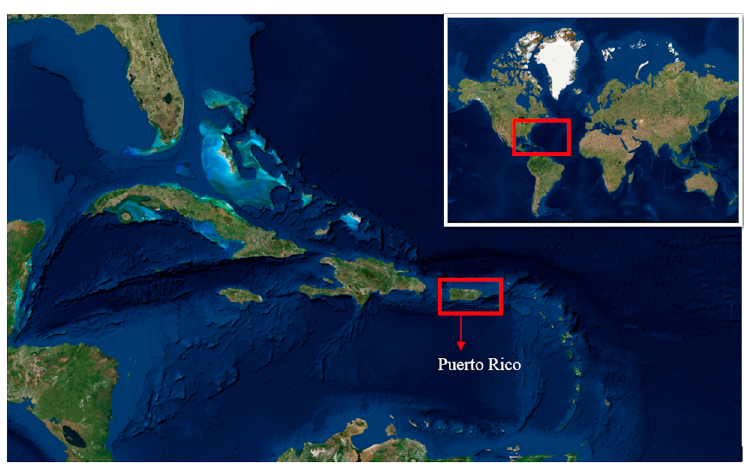
Figure 1. Location of Puerto Rico within the Caribbean. Puerto Rico is enclosed on the red rectangular and is located on the northwestern hemisphere. (Satellite Image Credit: Esri, DigitalGlobe, Earthstar Geographics, CNES/Airbus DS, GeoEye, USDA FSA, USGS, Getmapping, Aerogrid, IGN, IGP and the GIS User Community).